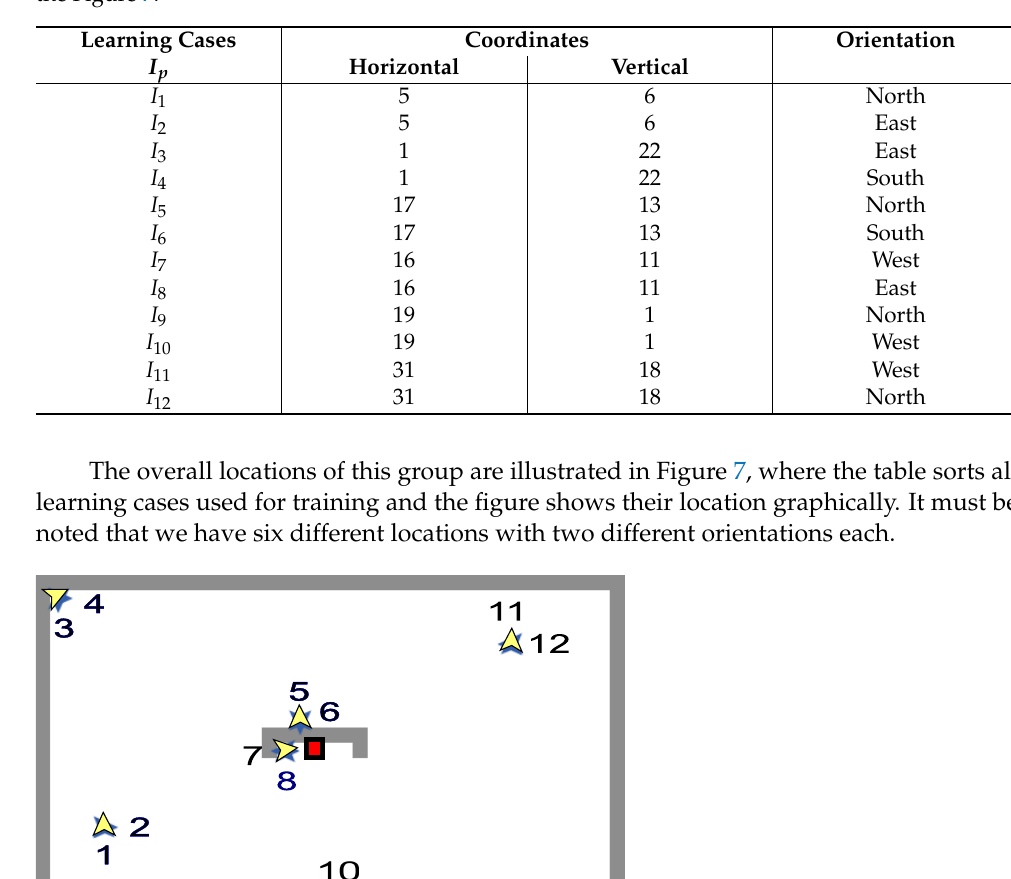
Table 2. List of 12 learning cases manually selected for the preliminary analysis, coordinates are refered to the origin located at the left bottom of the navigation environment and are depicted in the Figure 7.